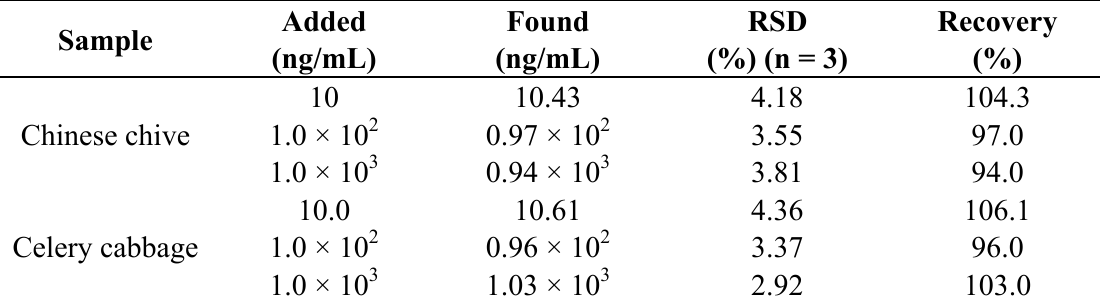
Table 2. The recovery of the proposed immunosensor in real